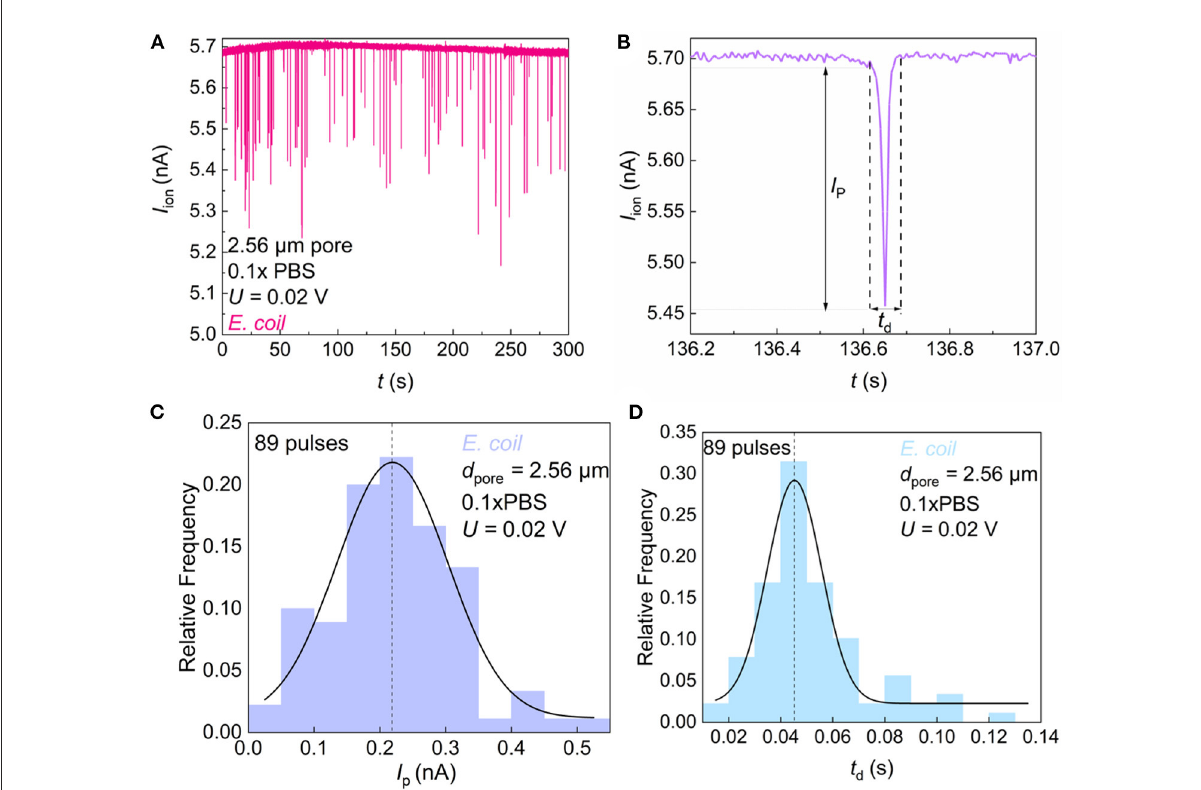
FIGURE4 Sensing of single E. coli by microfluidic SiN chip. (A) I ion vs. time ( t ) trace recorded in 0.1 × PBS containing E. coli with a micropore of diameter d pore = 2.56 µ m under U = 0.02V. (B) Magnified views of resistive pulses in (A) . I p and t d denote the pulse height and width. (C) Frequency distribution of E. coli resistance pulse height. (D) Frequency distribution of E. coli resistance pulse